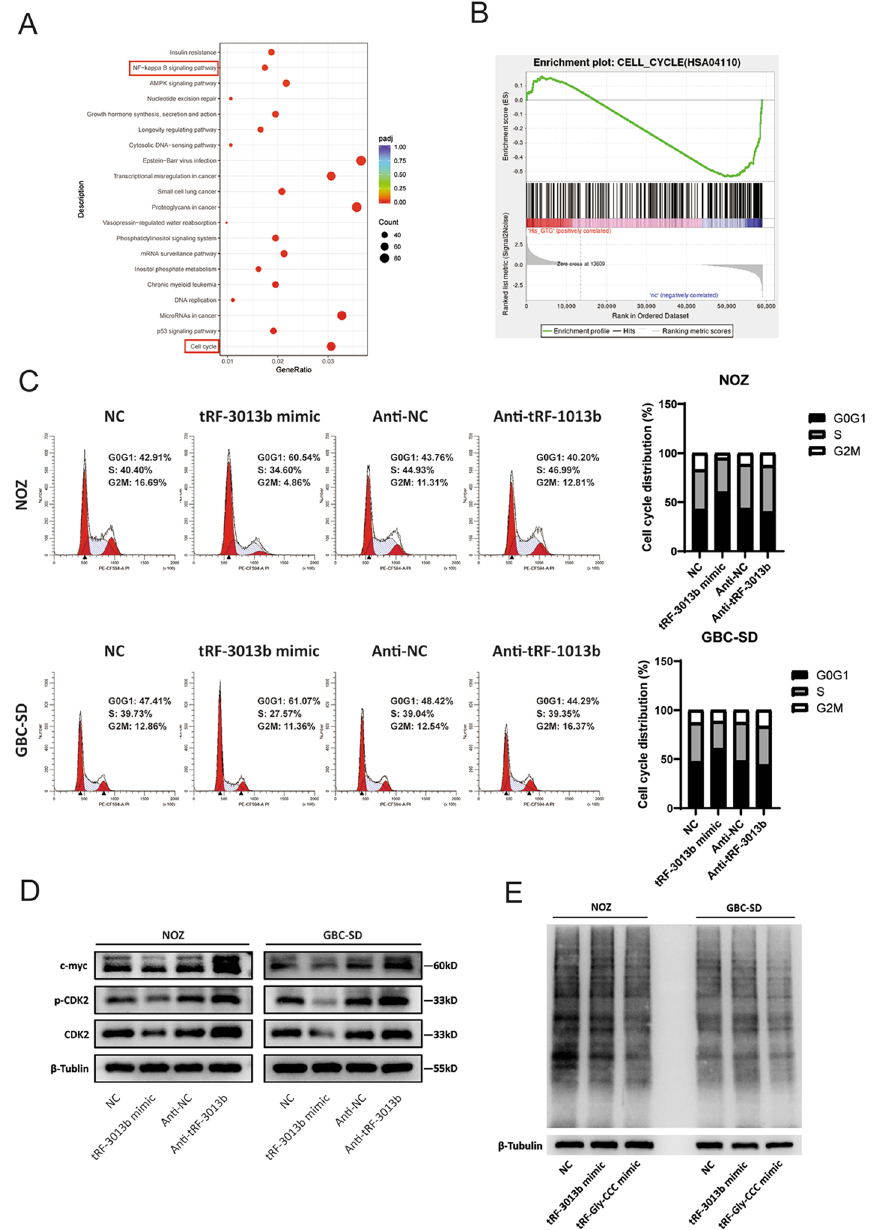
Fig. 4 tRF-3013b induced G1/S phase arrest in GBC cells. A KEGG rich distribution map showing the related pathways after transfection of NOZ with NC or tRF-3013b mimic. B Enrichment plot of cell cycle analyzed with GSEA after transfection with NC or tRF-3013b mimic in NOZ cells. C Cell-cycle assay after overexpression and inhibition of tRF-3013b in NOZ and GBC-SD cells. D Relative protein expression of c-myc, CDK2, and p-CDK2 after overexpression and inhibition of tRF-3013b in NOZ and GBC-SD cells. E Incorporation of puromycin and nascent peptides was detected to evaluated translation progression after transfection with NC, tRF-3013b mimic, or tRF-Gly-CCC mimic (positive control) in NOZ and GBC-SD